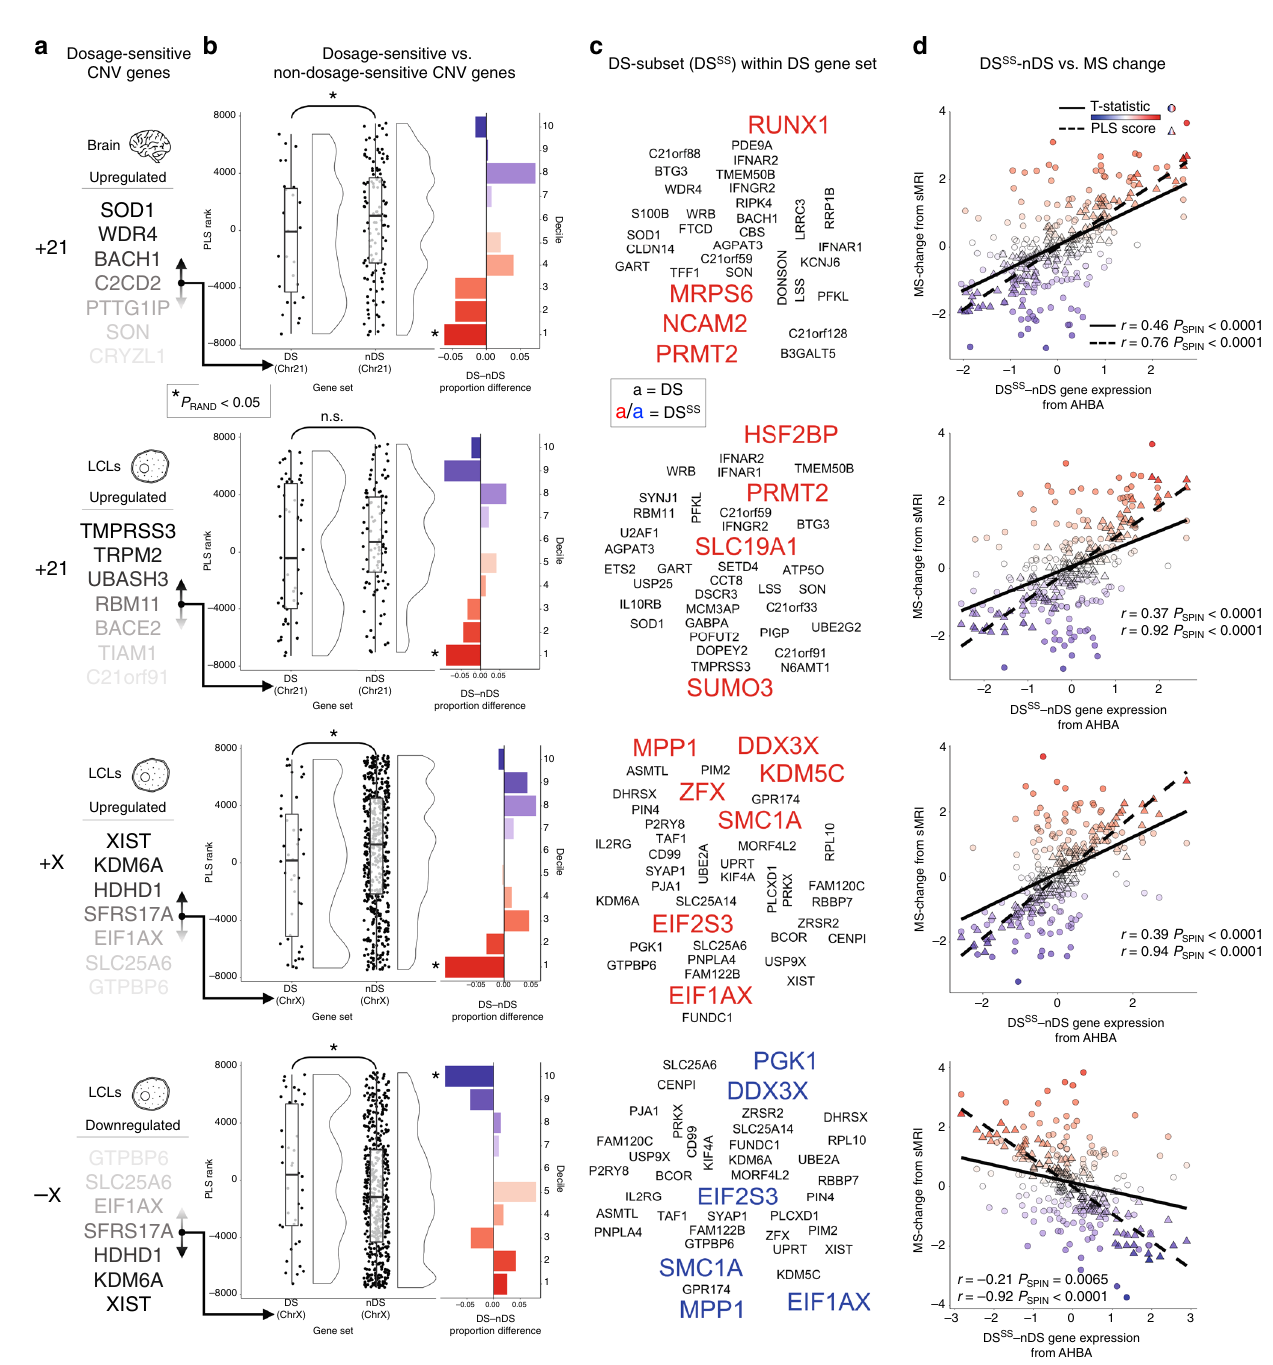
Fig. 3 CNV gene dosage sensitivity predicts spatial coupling of gene expression brain anatomy. a Top dosage-sensitive (DS) genes in brain tissue and blood-derived lymphoblastoid cell lines (LCLs) from CNV carriers (brain: + 21. LCLs: + 21, + X, − X, see “ Methods ” ). b Raincloud plots showing the different distributions of ranks for DS and non-DS (nDS) genes ( N genes per DS/nDS set provided in Supplementary Dataset 5). Boxplots show the median, interquartile range (IQR), and whiskers (1.5× IQR). Neighboring barplots show decile-speci fi c differences in proportions of DS vs. nDS genes. The statistically signi fi cant (*, P RAND < 0.05) median rank differences between DS and nDS gene sets are driven by a subset of DS genes (DS SS ), which are signi fi cantly enriched at extreme ranks. c DS SS gene names highlighted from the DS gene set. d Spatial correlations between DS SS − nDS differential gene expression and both regional PLS scores and regional MS change for each CNV. Colors represent high (blue) and low (red) rank. All permuted P values were not further corrected for multiple comparisons, and were determined based on one-sided tests of gene set enrichment (median rank; see “ Methods ”